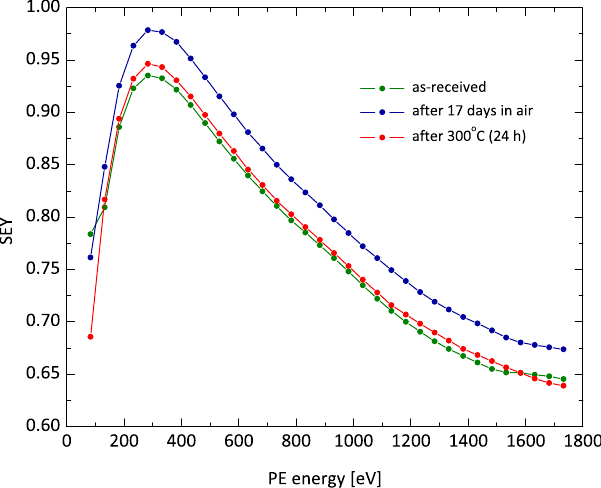
correlation.FIG. 4. SEY as a function of primary electron (PE) energy of amorphous carbon films tested for heavy-ion induced desorp- tion. The samples were measured after film deposition (as received), after 17 days of air exposure, and after bakeout at 300 (cid:3) C (24